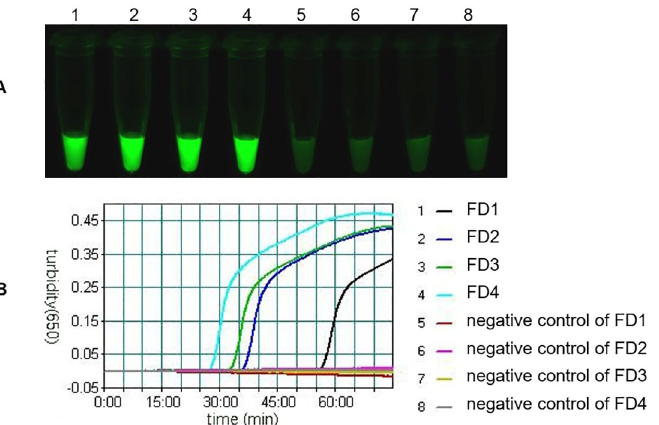
Fig 4. The effect of FD length on the mLAMP reaction. The mLAMP products amplified by using FMDV-specific composite probes with different lengths of FD were imaged using a 520 nm channel (A), and the turbidity curve was monitored by a real-time turbidimeter (B). 1: FD1 consists of 22 bases and is completely complementary to FMDV-F1c with a TM value of 64.2˚C, and the initial reaction time is 57.3 min; 2: FD2 consists of removing 3 bases from the 5’ end of FMDV-FD1 with a TM value of 57.1˚C, and the initial reaction time is 37.2 min; 3: FD3 consists of removing 6 bases from the 5’ end of FD1 with a TM value of 50.9˚C, and the initial reaction time is 34.2 min; 4: FMDV-FD4 consists of removing 9 bases from the 5’ end of FMDV-FD1 with a TM value of 39.4˚C, and the initial reaction time is 28.3 min; 5–8: negative controls of FD1-4.